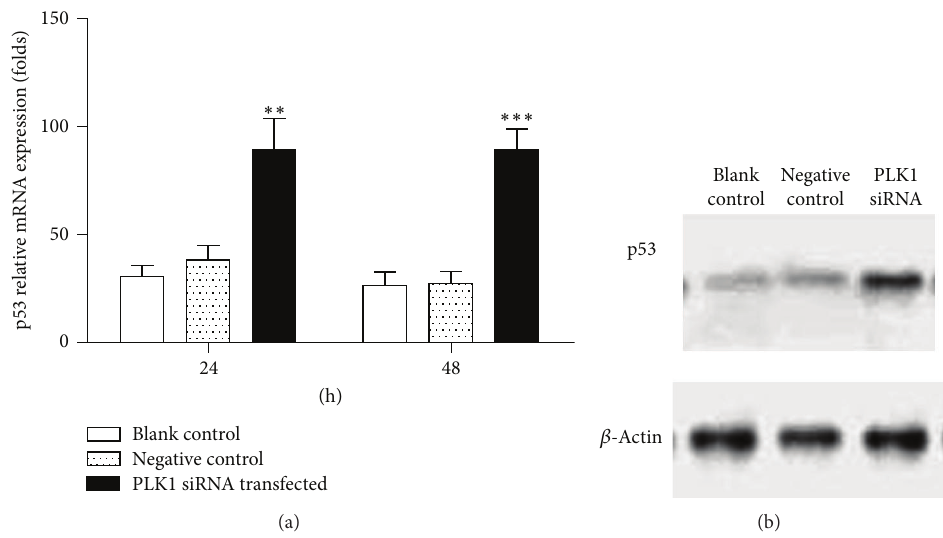
Figure 5: Knockdown of PLK1 in HCC upregulates the expression of p53. BCL-7402 cells were transfected with PLK1 siRNA. 48 h later, p53 expression was detected using real-time PCR (a) and western blot (b). Results are shown as mean ± SD. Data are representative of at least 3 independent experiments. ∗∗ 𝑃 < 0.01 ; ∗∗∗ 𝑃 < 0.001